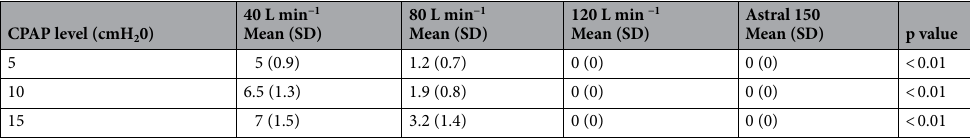
Table 1. Inspiratory CO 2 partial pressure at different flow rate and PEEP level. CPAP continuous positive airway pressure, SD standard deviation, PEEP positive end expiratory pressure, Astral 150 turbine-driven ventilator. p value ANOVA for repeated measures (same CPAP level with different